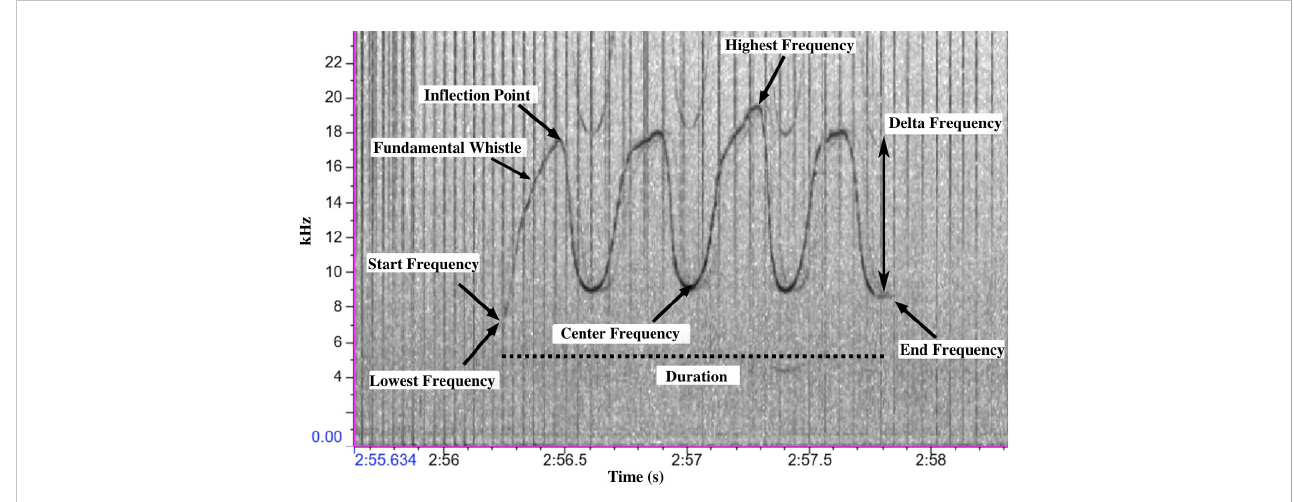
FIGURE 3 A spectrogram of whistle type F displaying the positions of the whistle parameters measured manually in Raven Pro